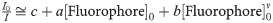
Degree of quenching against concentration.All of the curves were fitted with the modified Stern-Volmer equation for self-quenching: I0I≅c+a[Fluorophore]0+b[Fluorophore]0ν. The value of ν was 2.6, for Sulforhodamine B, 3.0 for FTIC and 0.04 for calcein.